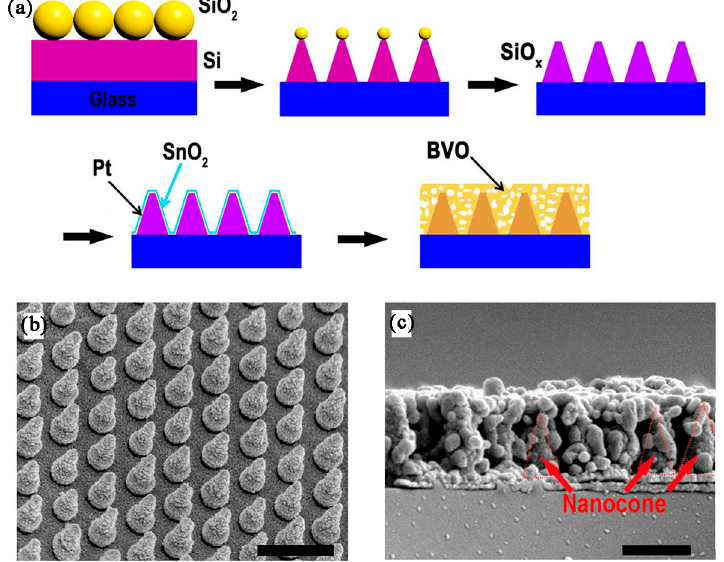
Figure 6. Pt/SnO 2 /Mo:BiVO 4 on an engineered nanocone substrate. ( a ) Schematic illustration of the fabrication process of the conductive nanocone substrate; ( b ) scanning electron microscope (SEM) image (60° tilting) of the final SiO x /Pt/SnO 2 nanocone arrays; ( c ) cross ‐ sectional SEM images of Mo:BiVO 4 on the SiO x /Pt/SnO 2 nanocone substrate. Some exposed nanocones were also marked in the figure ( c ). Scale bars, 500 nm. Images adapted and used under Creative Commons CC ‐ BY ‐ NC license, attributed to [90]. Reprinted with permission of from [90]. Copyright American Association for the Advancement of Science, 2016.